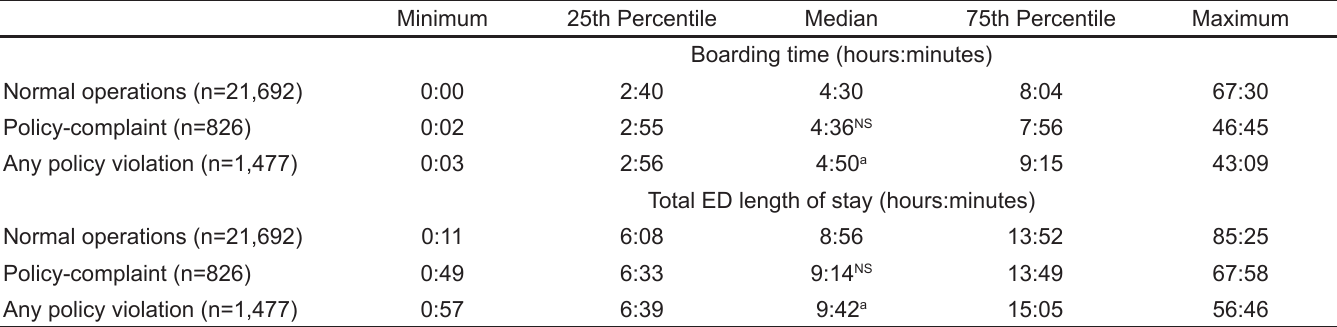
a p<0.001 for difference from normal operations, NS p>0.05 for difference from normal